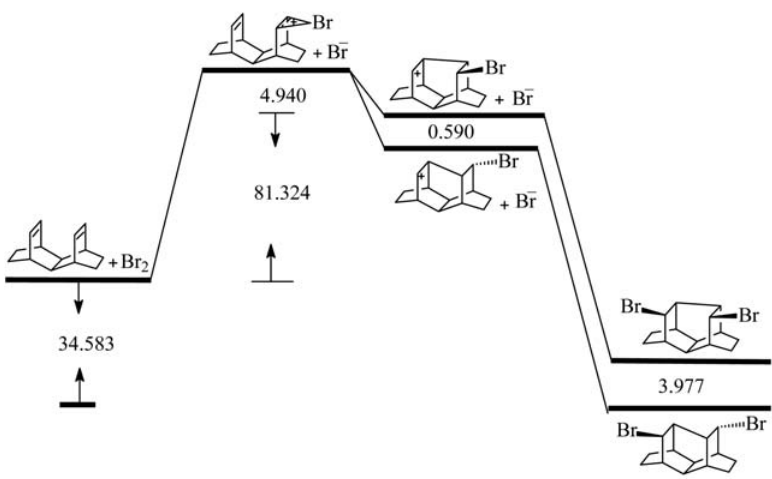
Figure 2. The energy diagram of TCTD-Br system (kcal mol –1 ) [ B3LYP/6-311++G(2d,2p)//B3LYP/6-311G(d,p) ] (The formations of N- and U- 2 type products are controlled by the relative energy of N- and U-type cationic intermadiates. And also, both products are formed because the relati- ve energies of the cations intermediates are low.)